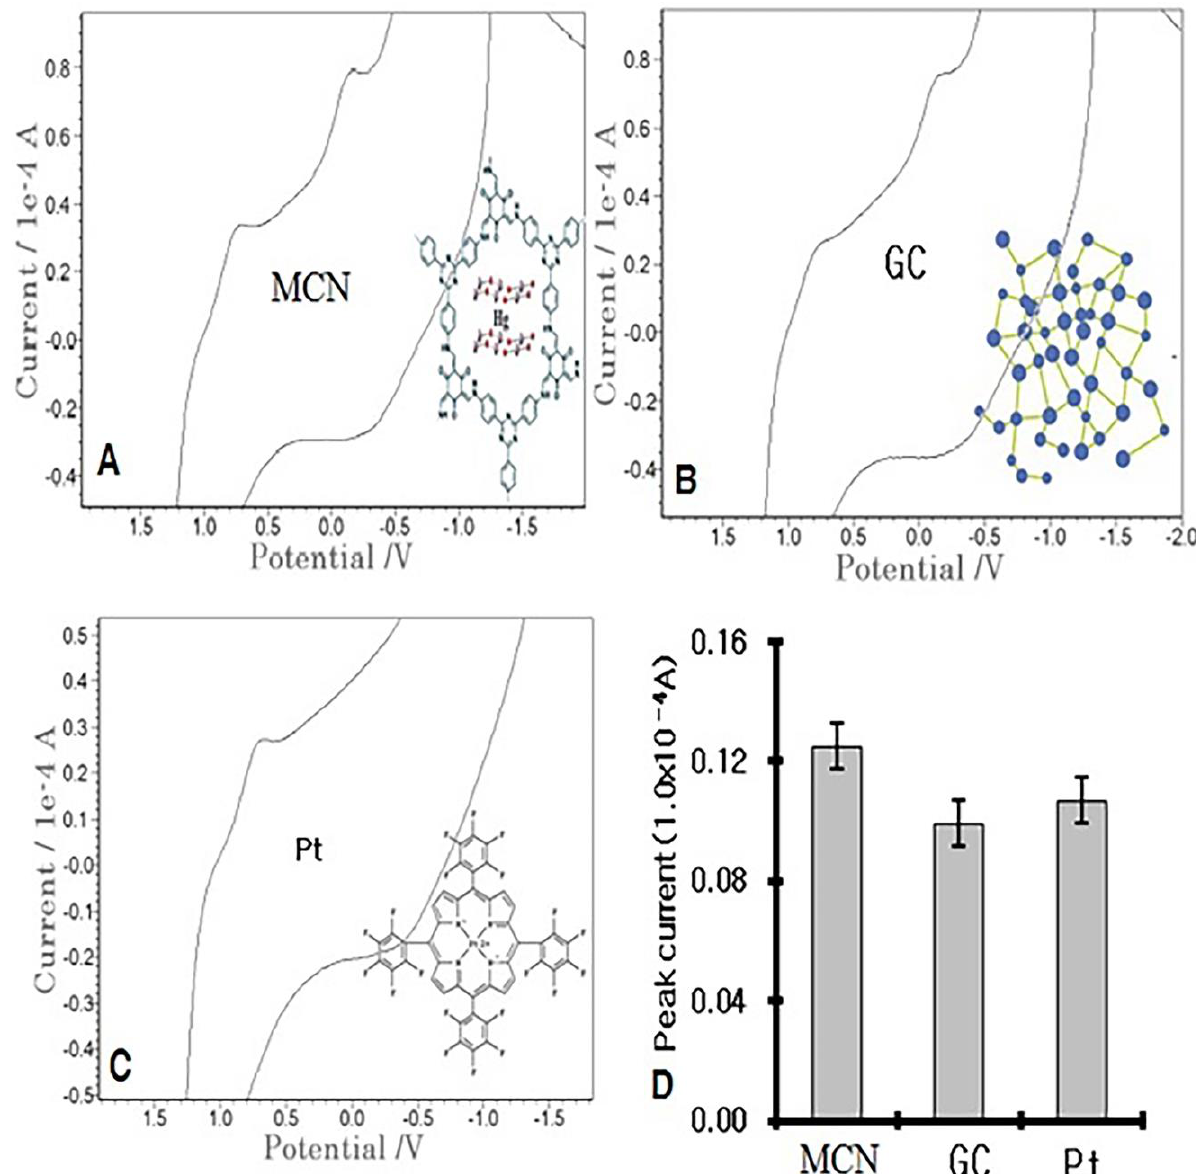
Figure 1. Cyclic voltammograms of the MCN ( A ), GC ( B ), and Pt ( C ) probes in an SV 1.0 × 10 − 3 L patient serum, with 30 s accumulation time, − 2.0 V initial potential, 2.0 V switching potential, 0.1 V/s scan rate, and the ionic oxidation peak current ( D ).